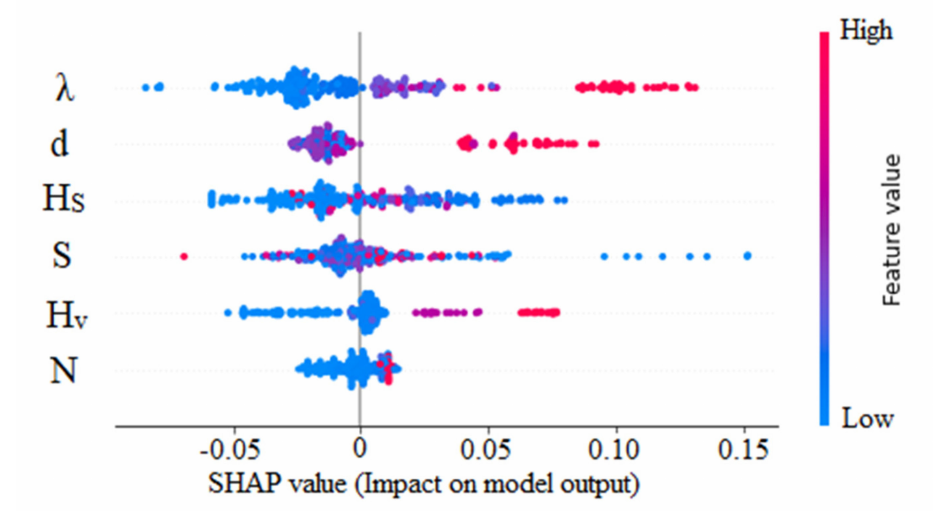
Figure 17. SHAP values of XGBoost model (f S